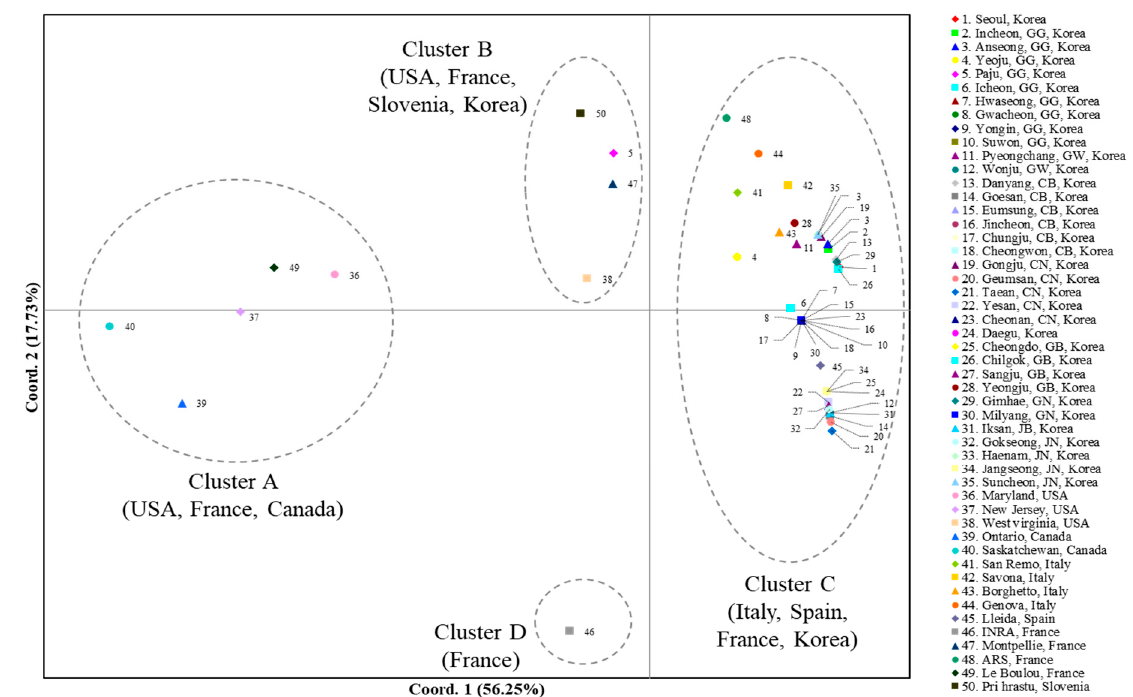
Figure 2. Results of the principal coordinate analysis (PCoA) based on collection localities using the worldwide COI data. The percentage variation explained by the first and second axes is indicated.